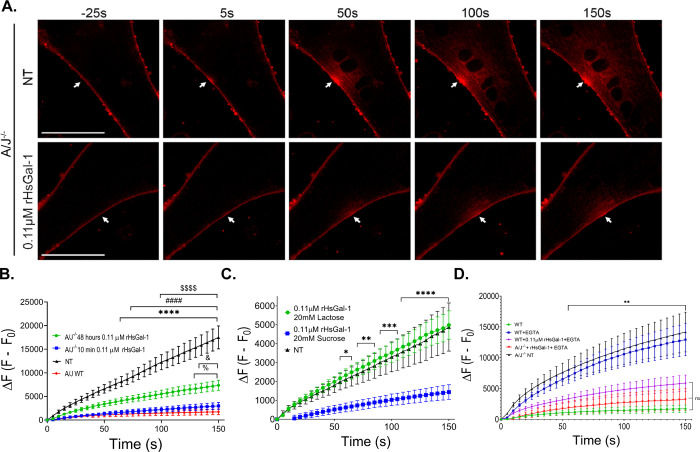
rHsGal-1 treatment increases membrane repair capacity in A/J-/- and A/J+/+ myotubes dependent on CRD activity.A. Representative images of FM 1–43 dye accumulation in NT and 48h 0.11 μM rHsGal-1 treated A/J-/- myotubes after injury with UV laser. White arrows indicate site of injury. B. Quantification of the change in fluorescent intensity inside A/J-/- myotubes following laser injury when treated with 0.11μM rHsGal-1 for 10min and 48h compared to WT A/J+/+ and NT A/J-/- myotubes. C. Change in the fluorescent intensity in 0.11μM rHsGal-1 treated A/J-/- myotubes supplemented with lactose and sucrose compared to NT A/J-/- myotubes. D. Change in the fluoresce intensity in 0.11μM rHsGal-1 treated A/J+/+ myotubes supplemented with or without EGTA and rHsGal-1 compared to WT A/J+/+ and NT A/J-/- myotubes. Values were measured by Tukey’s multiple comparison test and indicated by in B. ****p< 0.0001 A/J-/- NT vs A/J WT, ####p <0.0001 between A/J-/- NT vs A/J-/- 10min rHsGal-1, $ $ $ $p<0.0001 between A/J-/- NT vs A/J-/- 48hr rHsGal-1, %p<0.05 between A/J-/- 48hr rHsGal-1 and A/J WT, and & p<0.05 between 10min and 48h. C. *p<0.05, **p<0.01, ***p<0.001. and ****p< 0.0001 between A/J-/- 0.11μM rHsGal-1 20mM sucrose vs. A/J-/- 0.11μM rHsGal-1 20mM lactose and A/J-/- NT. D. at least significance of **p<0.01 between A/J WT, AJ WT + EGTA + 0.11μM rHsGal-1, and A/J-/- 0.11μM rHsGal-1 + EGTA vs. A/J-/- + EGTA and A/J WT + EGTA Scale bars = 50 μm. Error bars represent SEM. n ≥ 11 from 2 independent experiments for each group.